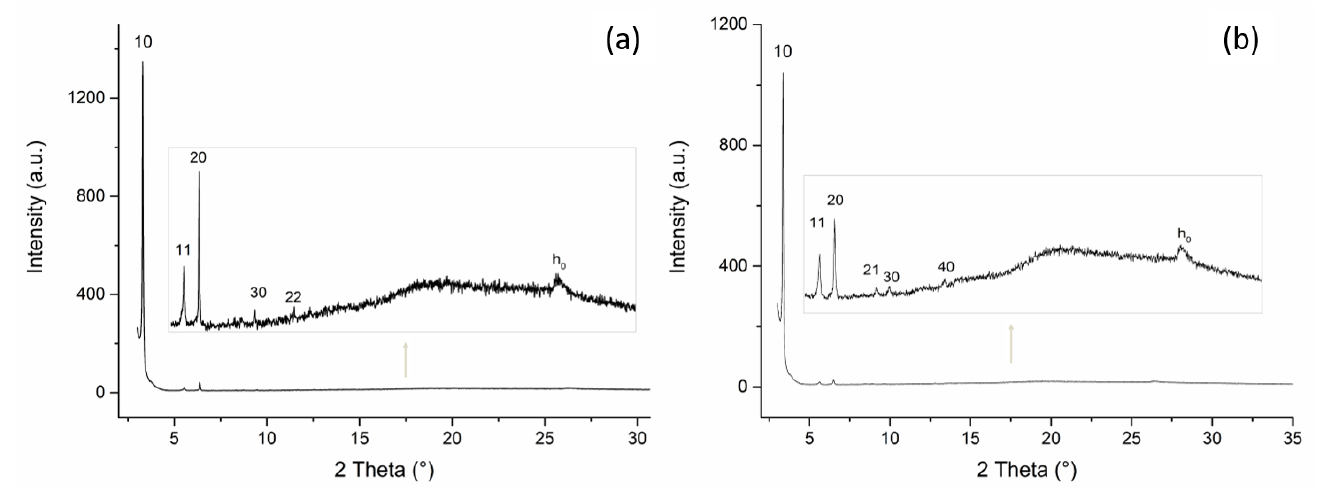
Figure 3. PXRD patterns of the mesophase of complex Zn/Fe registered upon cooling (second cycle) at 85 °C ( a ) and at 25 °C ( b ). Table 1. Indexation of the PXRD spectra of the mesophase upon cooling at 85 °C and at 25 °C.